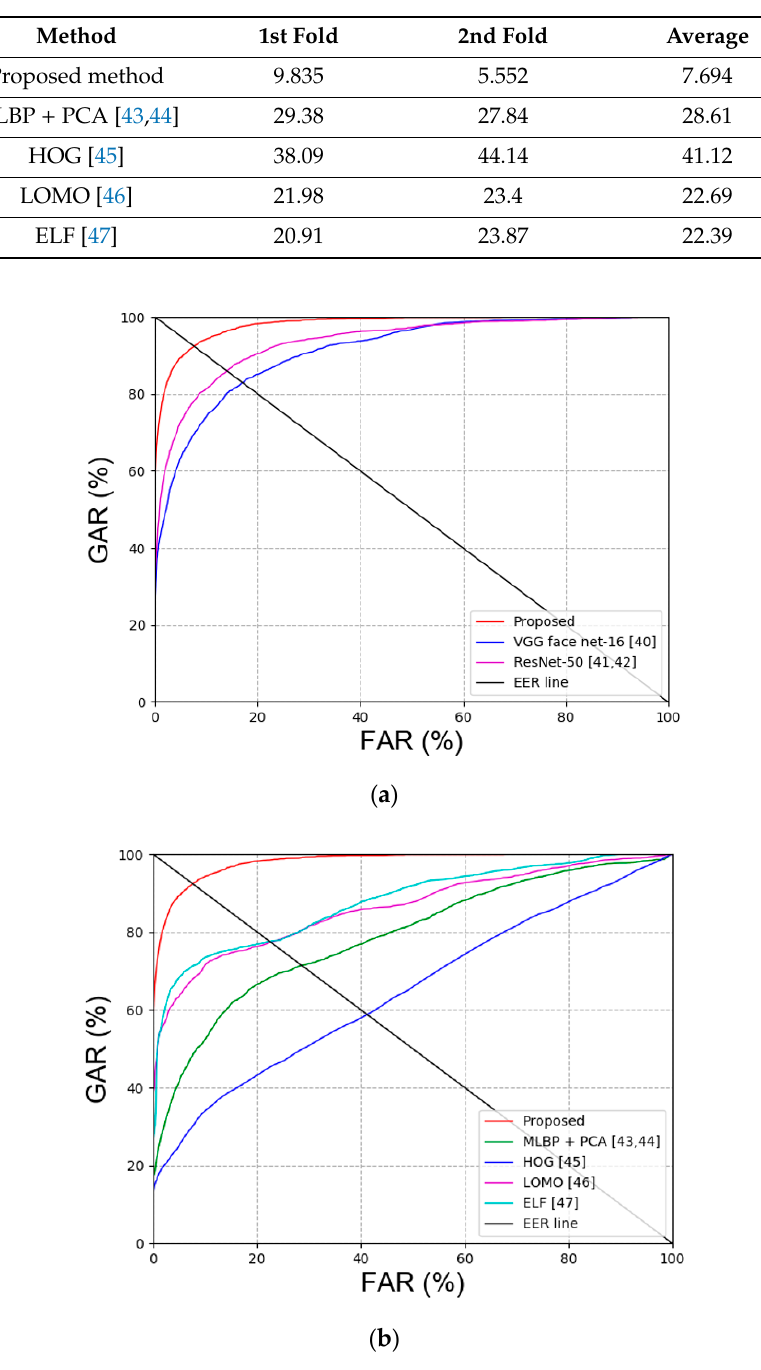
Figure 9. ROC curves obtained via comparing proposed and the state-of-art-methods. ( a ) Face image recognition results and ( b ) face and body image recognition results.